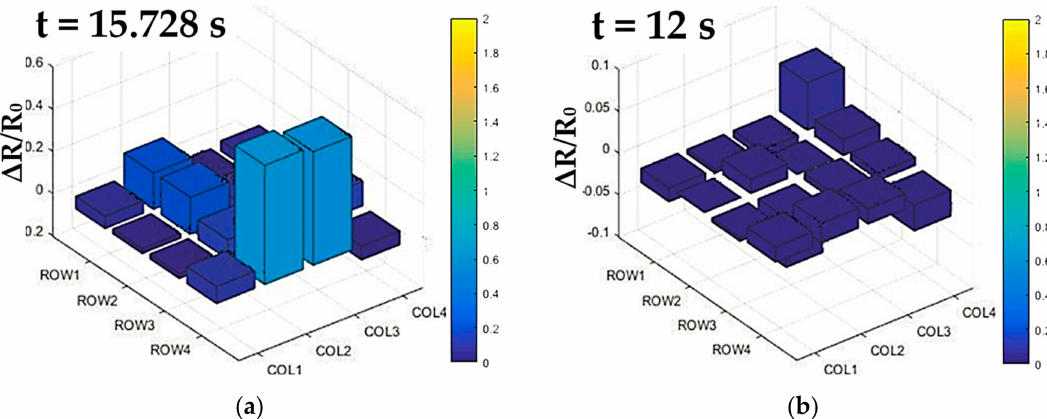
Figure 12. The tactile data from the 3D flexible tactile sensor array in a real-time manner during the security test: ( a ) Tactile data before the collision; ( b ) Tactile data when the collision